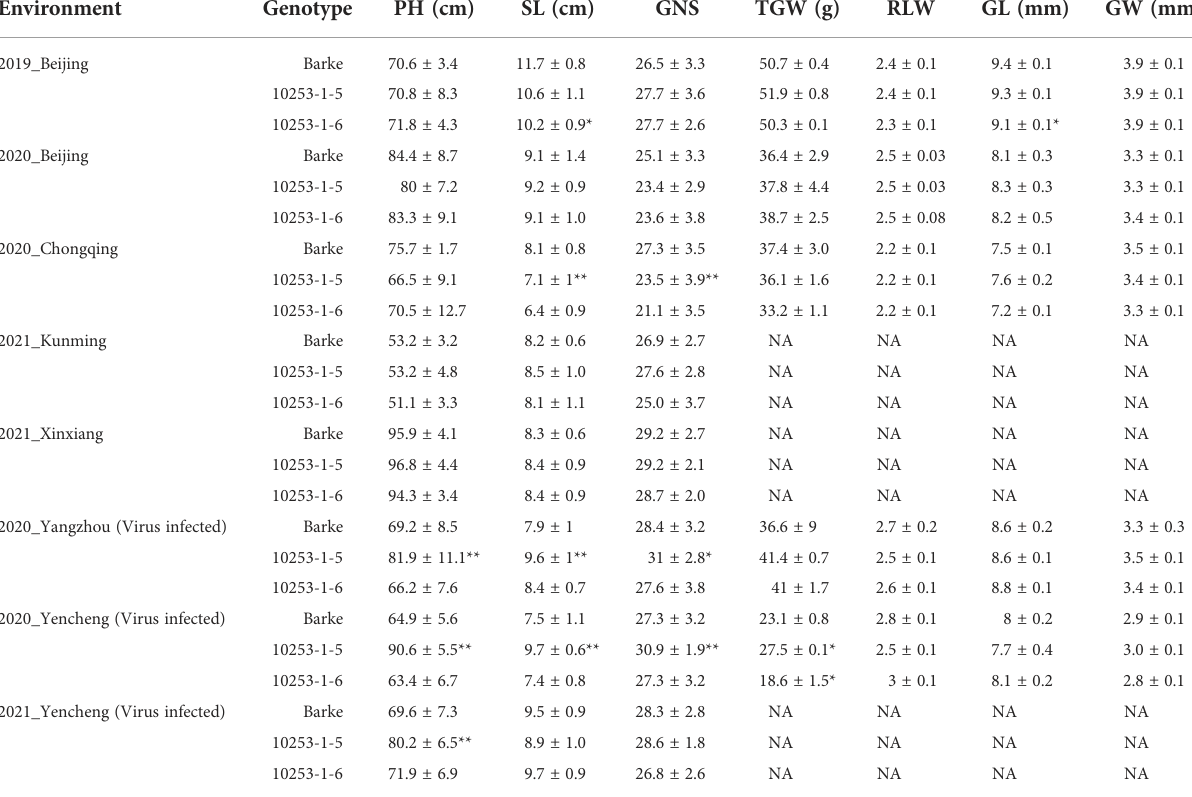
TABLE 2 Field performance of ‘ Barke ’ , the EMS-induced pdil5-1 mutant (10253-1-5), and its non-mutated sibling line (10253-1-6) in six locations in three years.